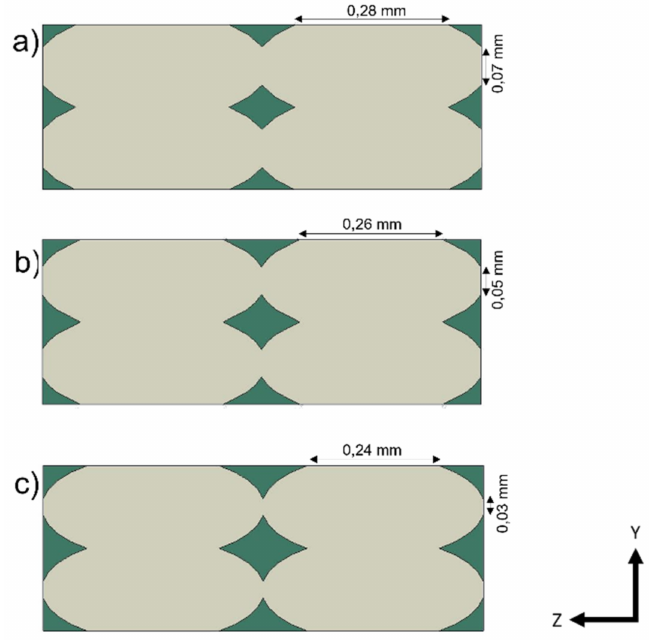
Figure 8. Increased RVE void length dimensions in Y and Z directions, respectively: ( a ) lengths of 0.07 and 0.28 mm; ( b ) lengths of 0.05 and 0.26 mm; ( c ) lengths of 0.03 and 0.24 mm.